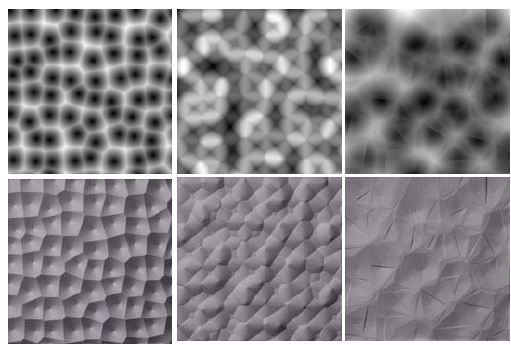
Figure 7. Textures generated by cellular algorithms. First, row: height maps. Second row: relighting results.